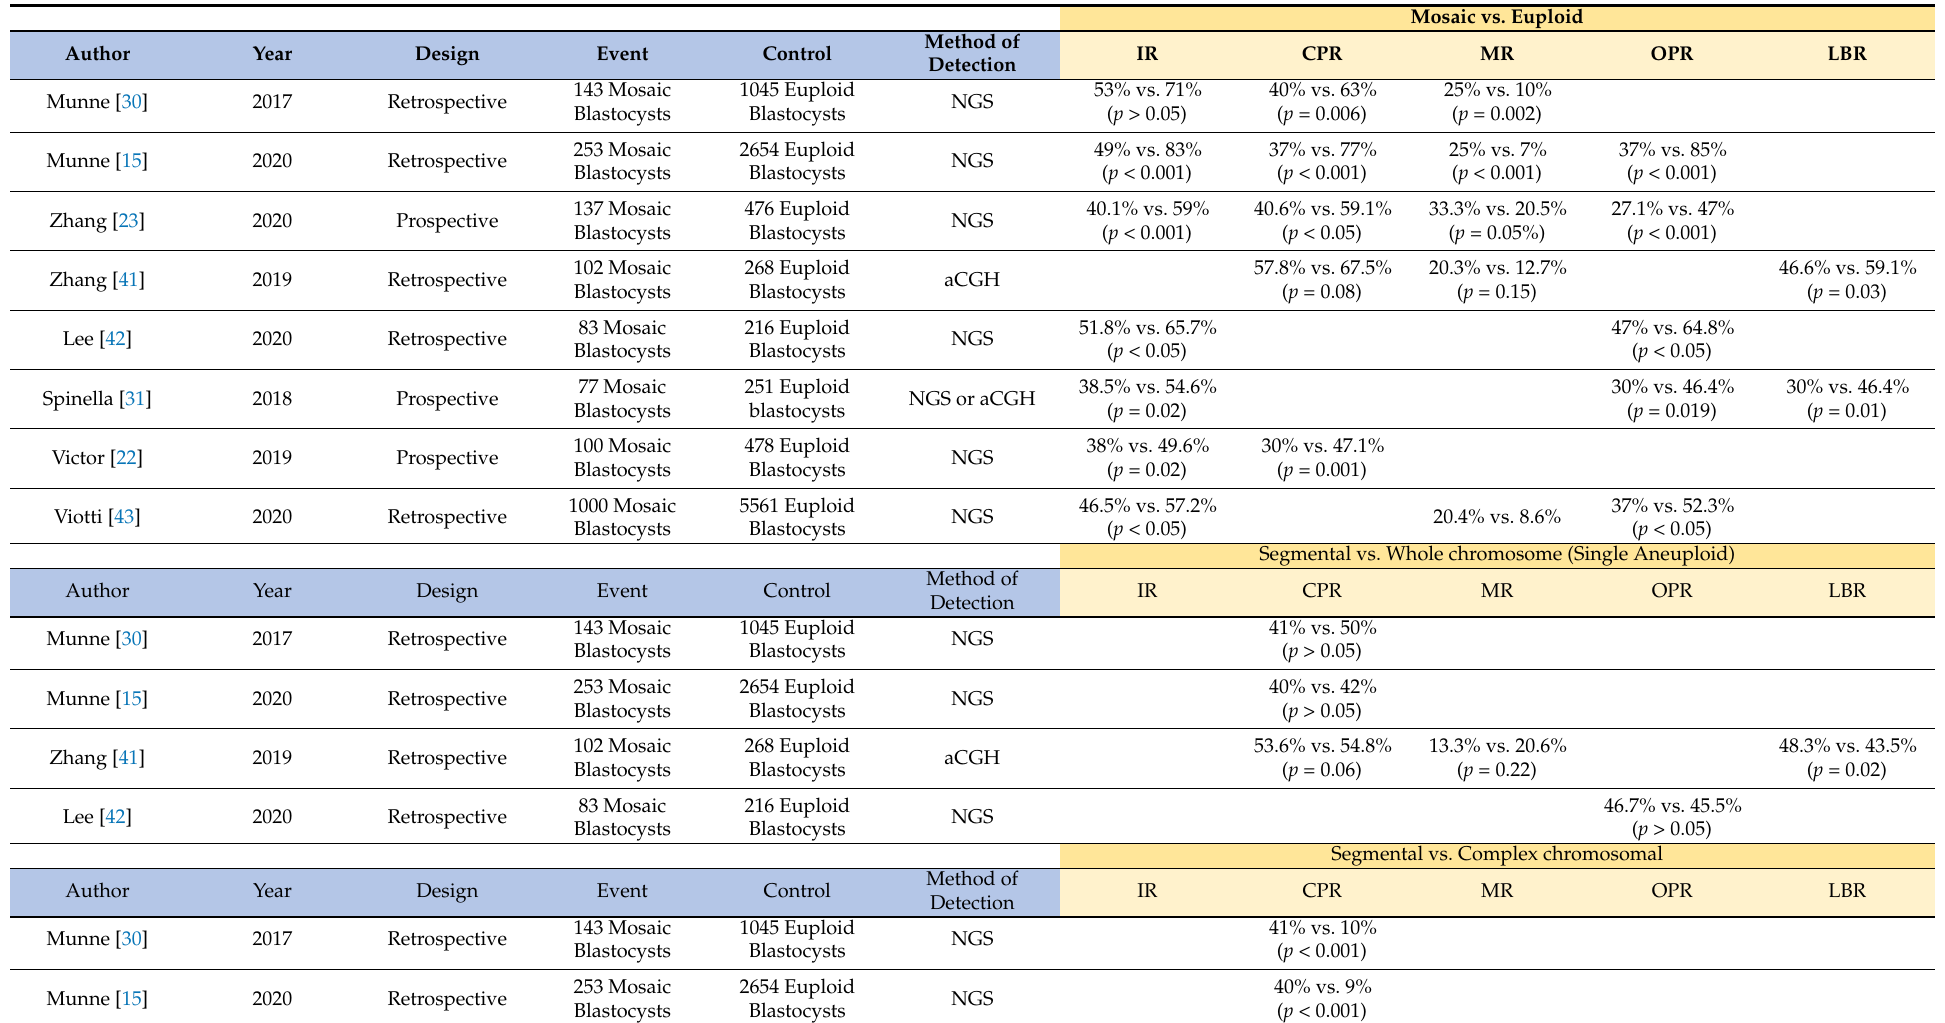
Table 1. Clinical outcomes after mosaic embryo transfer (MET).